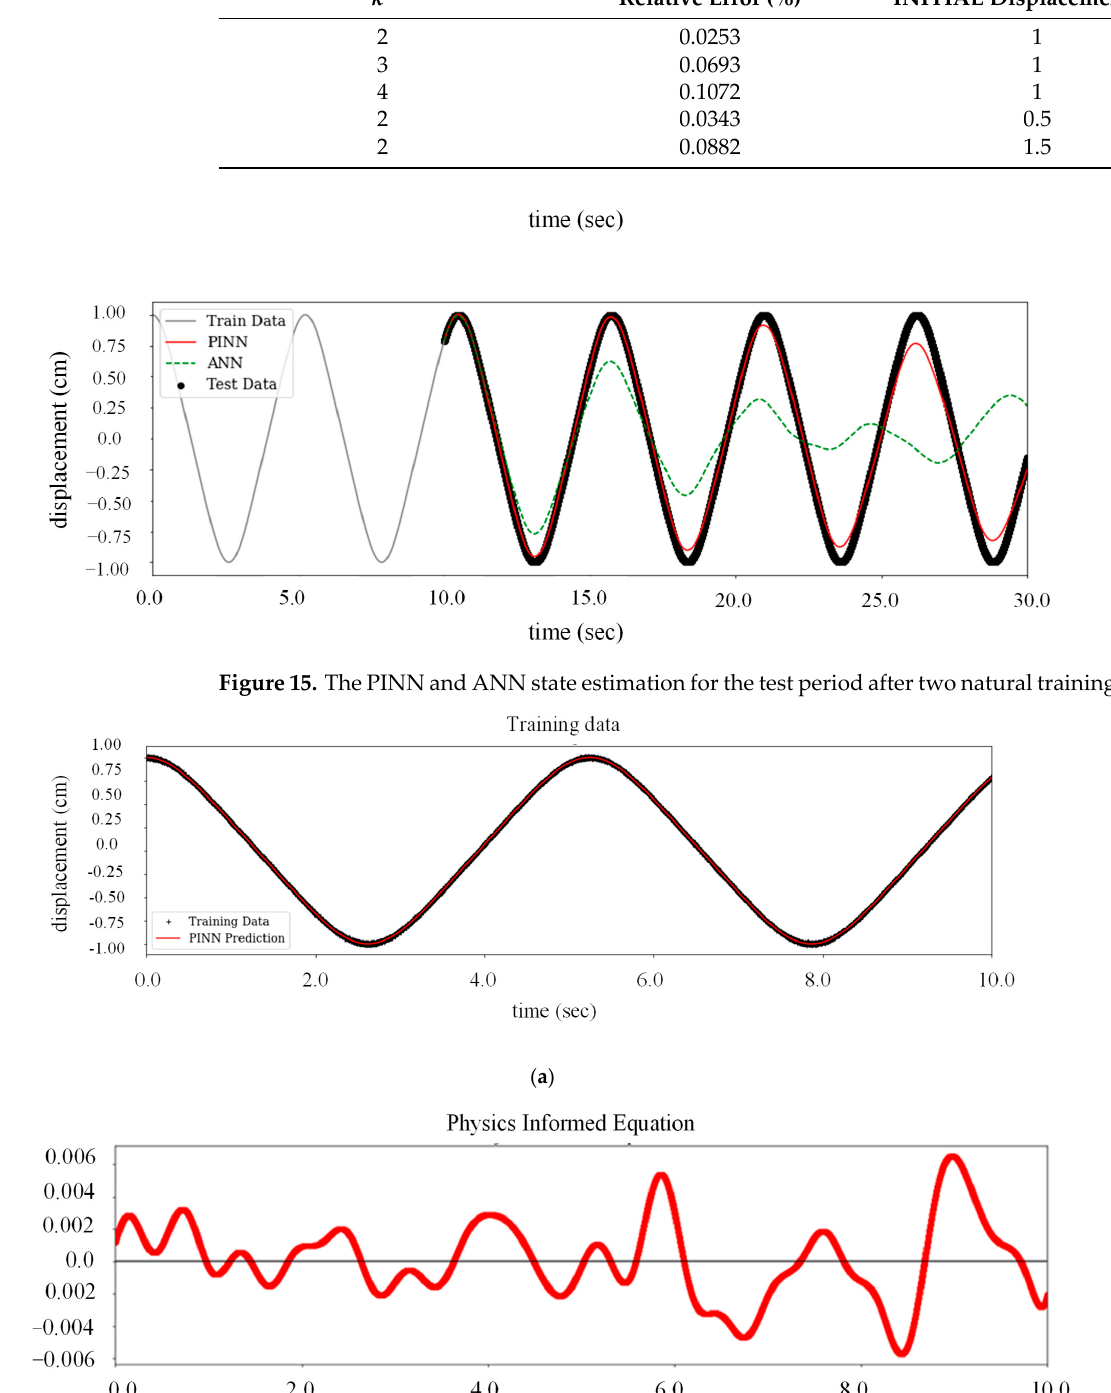
Figure 17. Loss function of the PINN.